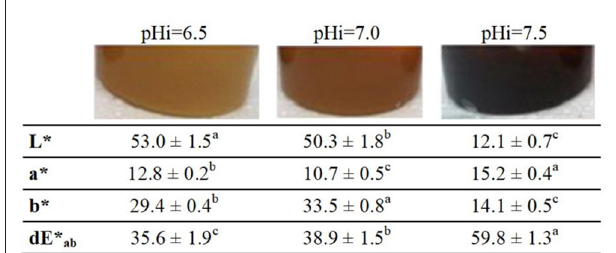
FIGURE 2 | Color parameters of DL elaborated at different pH i values. Results are expressed as mean ± SD of two production batches. Different letters indicate significant differences between groups ( α ≤ 0.05).